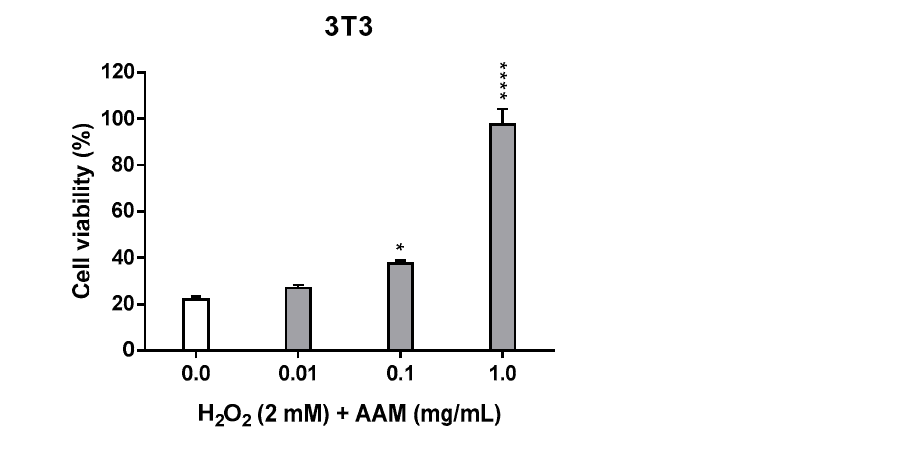
Figure 4. Cellular repair activity of AAM in 3T3 cells. Cells previously treated with 2 mM H 2 O 2 for 2.5 h were incubated in the absence (white column) or in the presence of AAM for 24 h (gray columns) and finally cell viability was determined by MTT assay and expressed as a percentage with respect to untreated cells. H 2 O 2 cell viability in absence of the extract was used as a positive control. Results are expressed as mean ± standard error of n = 3. A two-way analysis of variance (ANOVA) and a Bonferroni post hoc assay have been performed. Statistical differences were considered as follows: * p ≤ 0.05, and **** p ≤ 0.0001 in comparison with positive control.